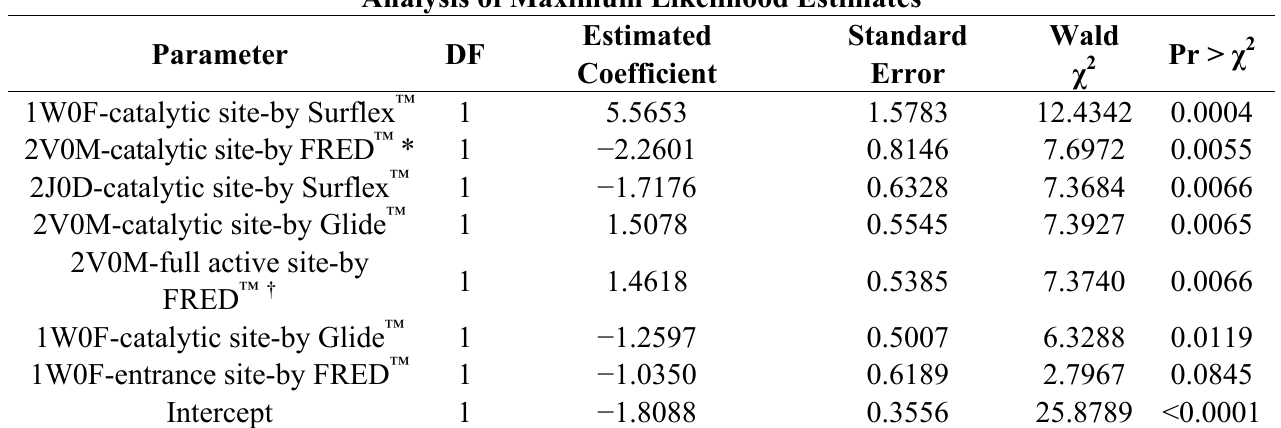
Table 3. Summary of the final DLR